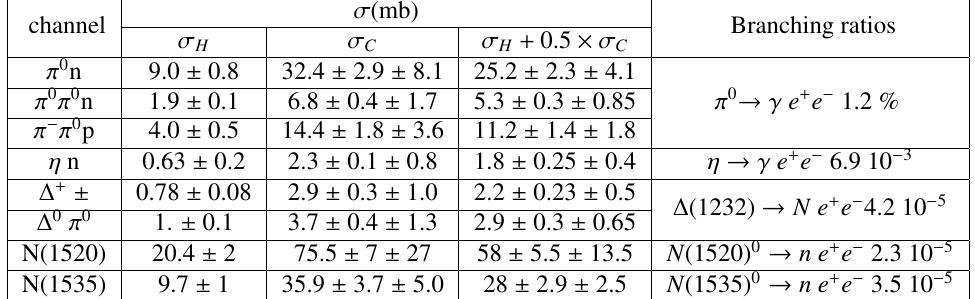
Table 1. Cross sections for the di ff erent channels implemented in the simulation for interactions of π − with incident momentum of 0.685 GeV / c with proton, carbon and polyethylene targets. For the carbon and polyethylene targets, the first uncertainty is related to the elementary cross sections used in the participant-spectator approach, as given in the first column and the second to the ratio of carbon to proton cross section. The last column gives the branching ratio to the e + e − channel.